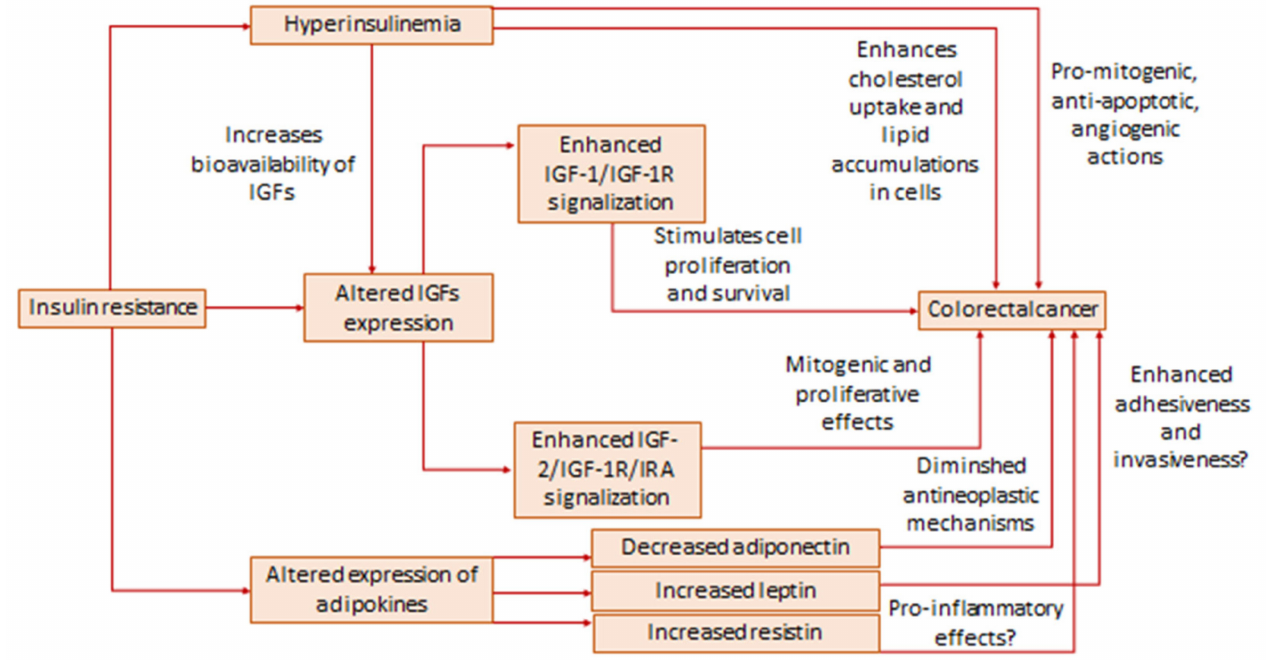
Figure 1. The role of insulin resistance in pathogenesis of CRC. Apart from hyperinsulinemia, IR is characterized by altered activities of IGFs.